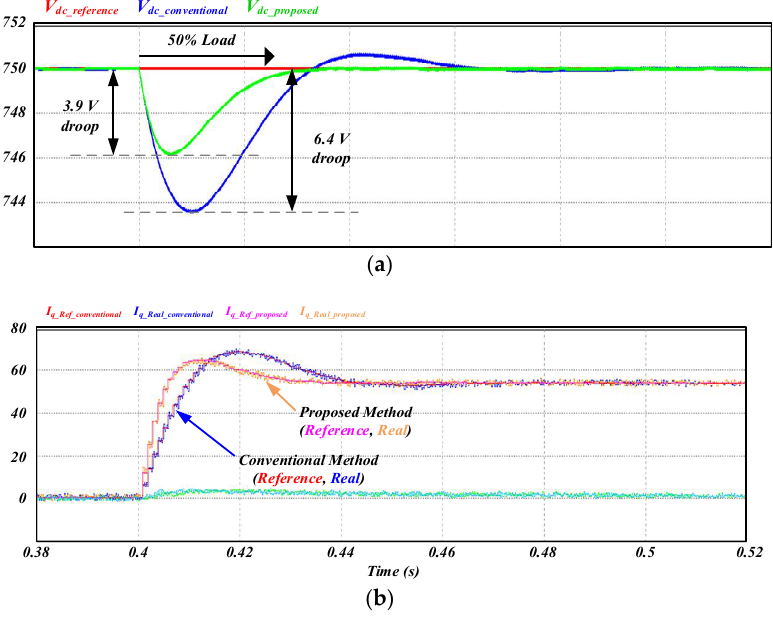
Figure 10. V dc and q -axis response characteristic (expanded). ( a ) Comparison of DC voltage dynamic responses at load connection; and ( b ) comparison q -axis current control characteristic.